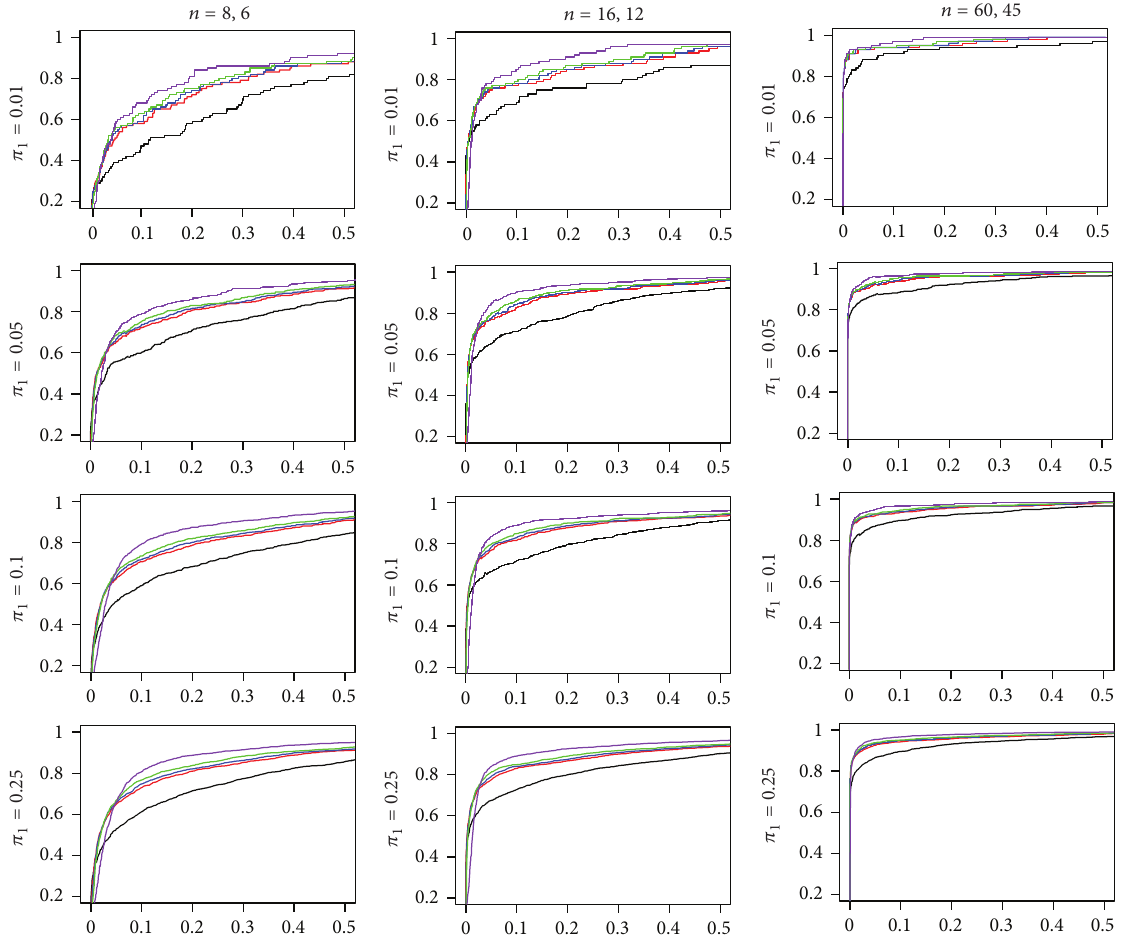
F 1: ROC curves for the t- statistic (black line), s 30-statistic (red line), s 50-statistic (blue line), s 70-statistic (green line), and s 90-statistic (purple line) in a type EV simulation. In each plot the horizontal axis is the false positive fraction and the vertical axis is the true positive fraction. e sample sizes in the two groups vary from 8 and 6 (le column) to 60 and 45 (right column). differentially expressed